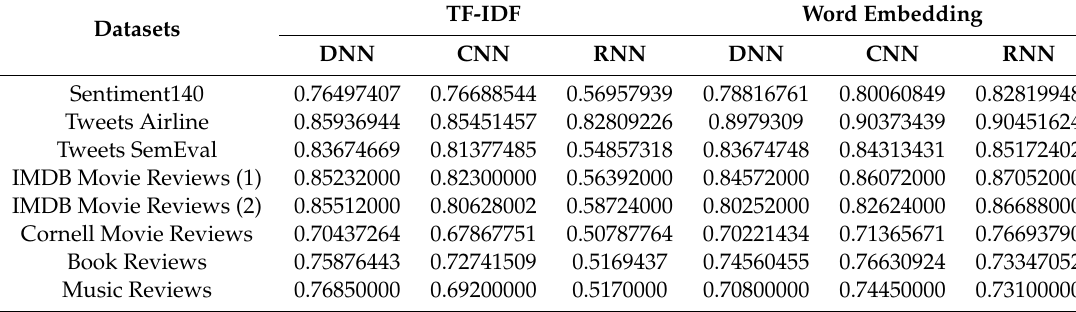
Table 2. Accuracy comparison for datasets with two classes (positive and negative).